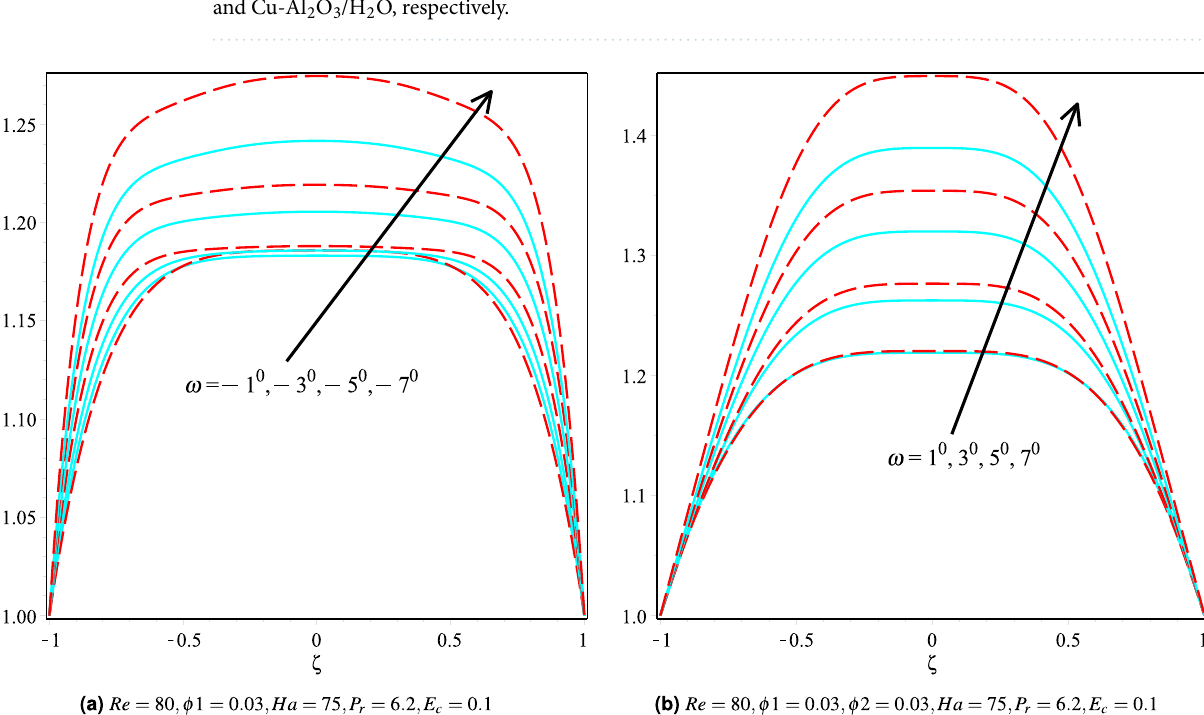
Figure 4. The heat boundary layers distribution in converging and diverging channel with particular ω for Cu/ H 2 O and Cu-Al 2 O 3 /H 2